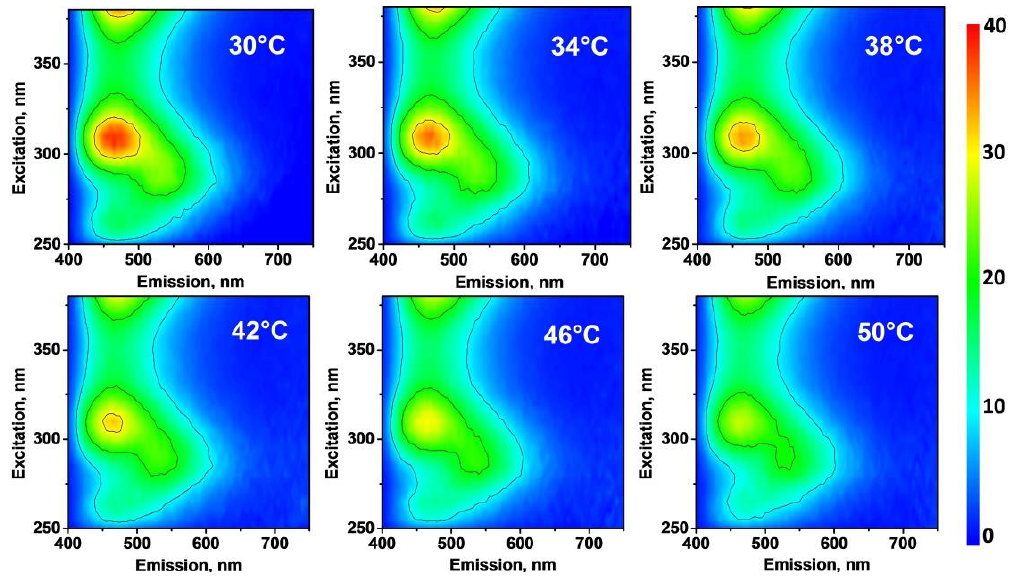
Figure 4. Temperature-dependent PL excitation/emission maps of colloidal solution of O, N-CDs in water at 0.625 g/L.